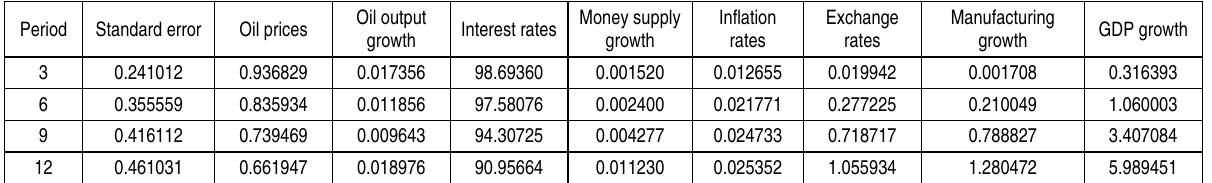
Table 1. Variance decomposition of interest